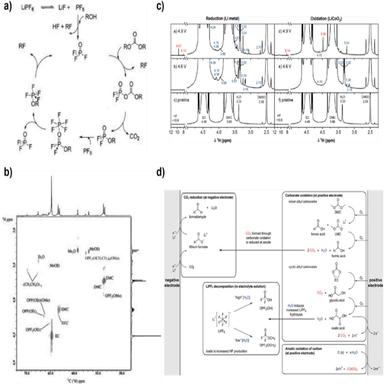
.1. (a) Schematic of the proposed autocatalytic thermal decomposition of LiPF6 salts in Li-ion battery electrolyte. PF5 reacts with protic impurities in the solution, which starts the autocatalytic process. (b) 1 H-13C HETCOR NMR spectrum of an aged electrolyte solution containing 1 M LiPF6 in EC:DEC:DMC. Signals corresponding to EMC indicate that a transesterification reaction occurs during electrolyte decomposition. (c) Representative 1 H NMR spectra collected from a Li metal/LiCoO2 cell on either side of